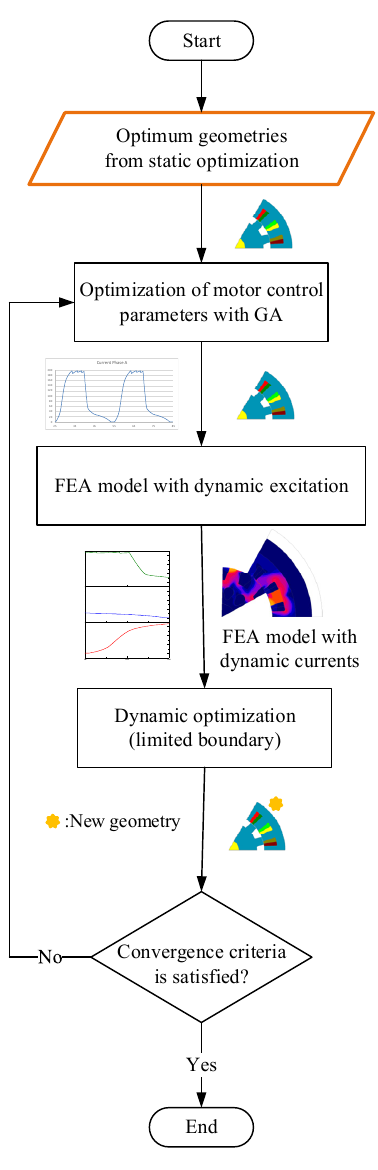
Rotor pole arc angle [deg] Figure 5. Illustration of static design results with respect to the three geometry parameters with highest correlation to average torque.